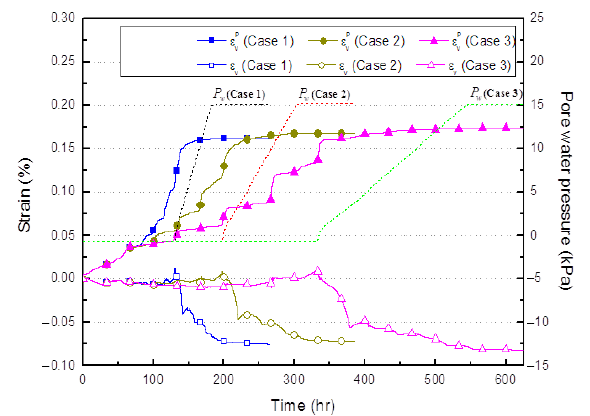
Fig. 20. Time histories of vertical skeleton stress of core (at Element 1048) and pore water pressure applying to core of levee (at Element